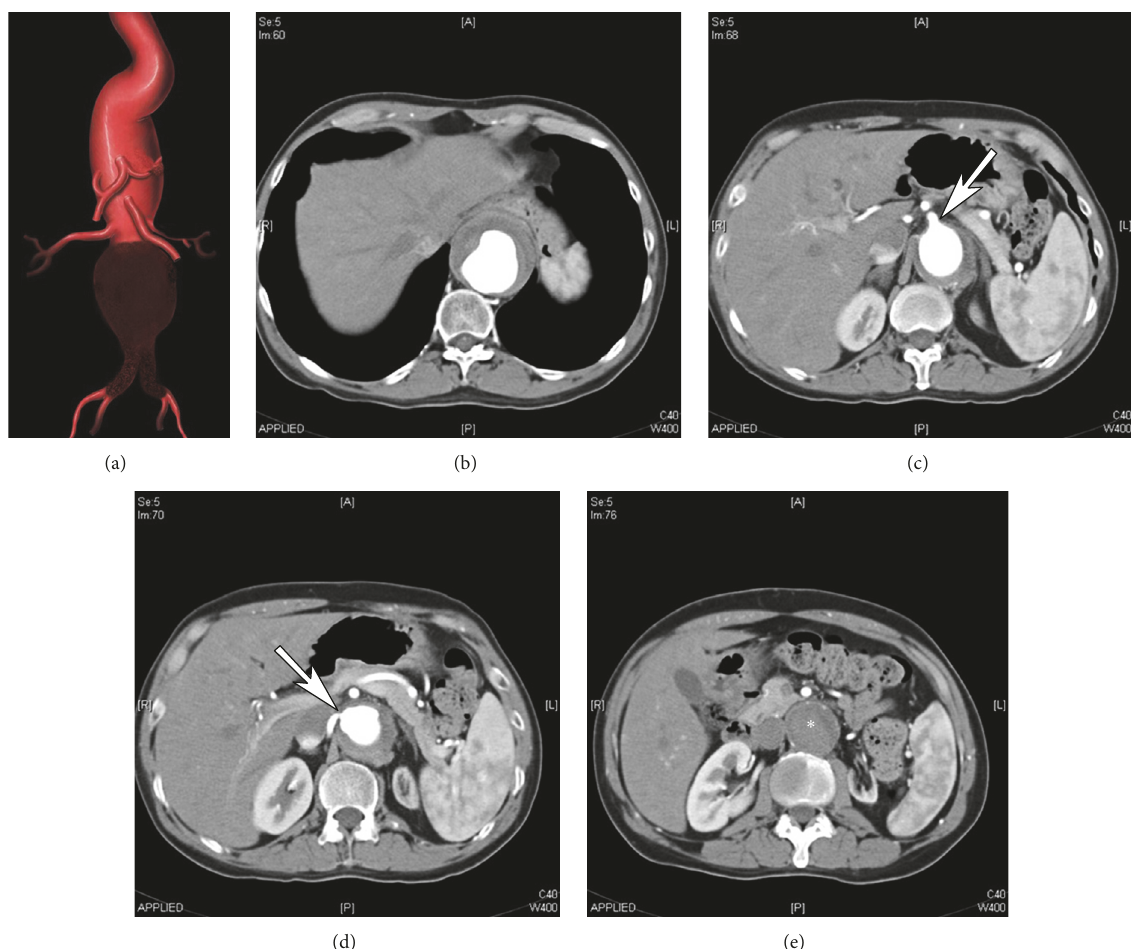
Figure1:AnillustrationshowinglargetypeIIICrawfordthoracoabdominalaneurysm(TAAA)withextensiveinfrarenalsegmentthrombosis and left renal artery occlusion (a). Axial computed tomography angiogram showing the distal thoracic aorta measuring 65 mm (b), celiac artery origin (arrow in (c)), right renal artery stenosis (arrow) and left renal artery occlusion with left renal atrophy (d), and thrombosed infrarenal component of the TAAA (asterisk) measuring 42 mm